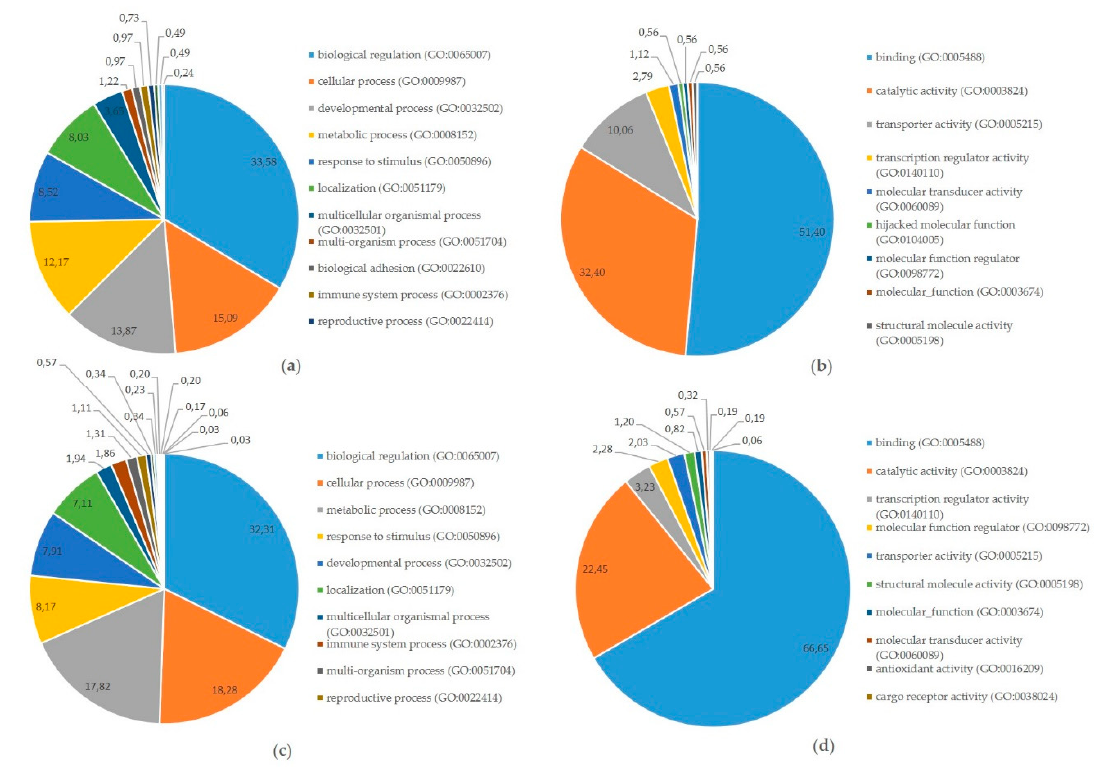
Figure 5. Involvement of targets of di ff erentially expressed microRNAs at the equine embryo–maternal interface in Gene Ontology (GO) pathways: ( a ) Categorization in GO biological processes of proteins and mRNAs targeted by miRNAs di ff erentially expressed in pregnant vs. cyclic horses as presented in (Table 1); ( b ) Categorization in GO Molecular functions of proteins and mRNAs targeted by miRNAs di ff erentially expressed in pregnant vs. cyclic horses (Table 1); ( c ) Categorization in GO Biological processes of miRNA-mRNA target pairs di ff erentially expressed between the embryo and the endometrium of pregnant mares; ( d ) Categorization in GO Molecular functions of miRNA-mRNA target pairs di ff erentially expressed between the embryo and the endometrium of pregnant mares.